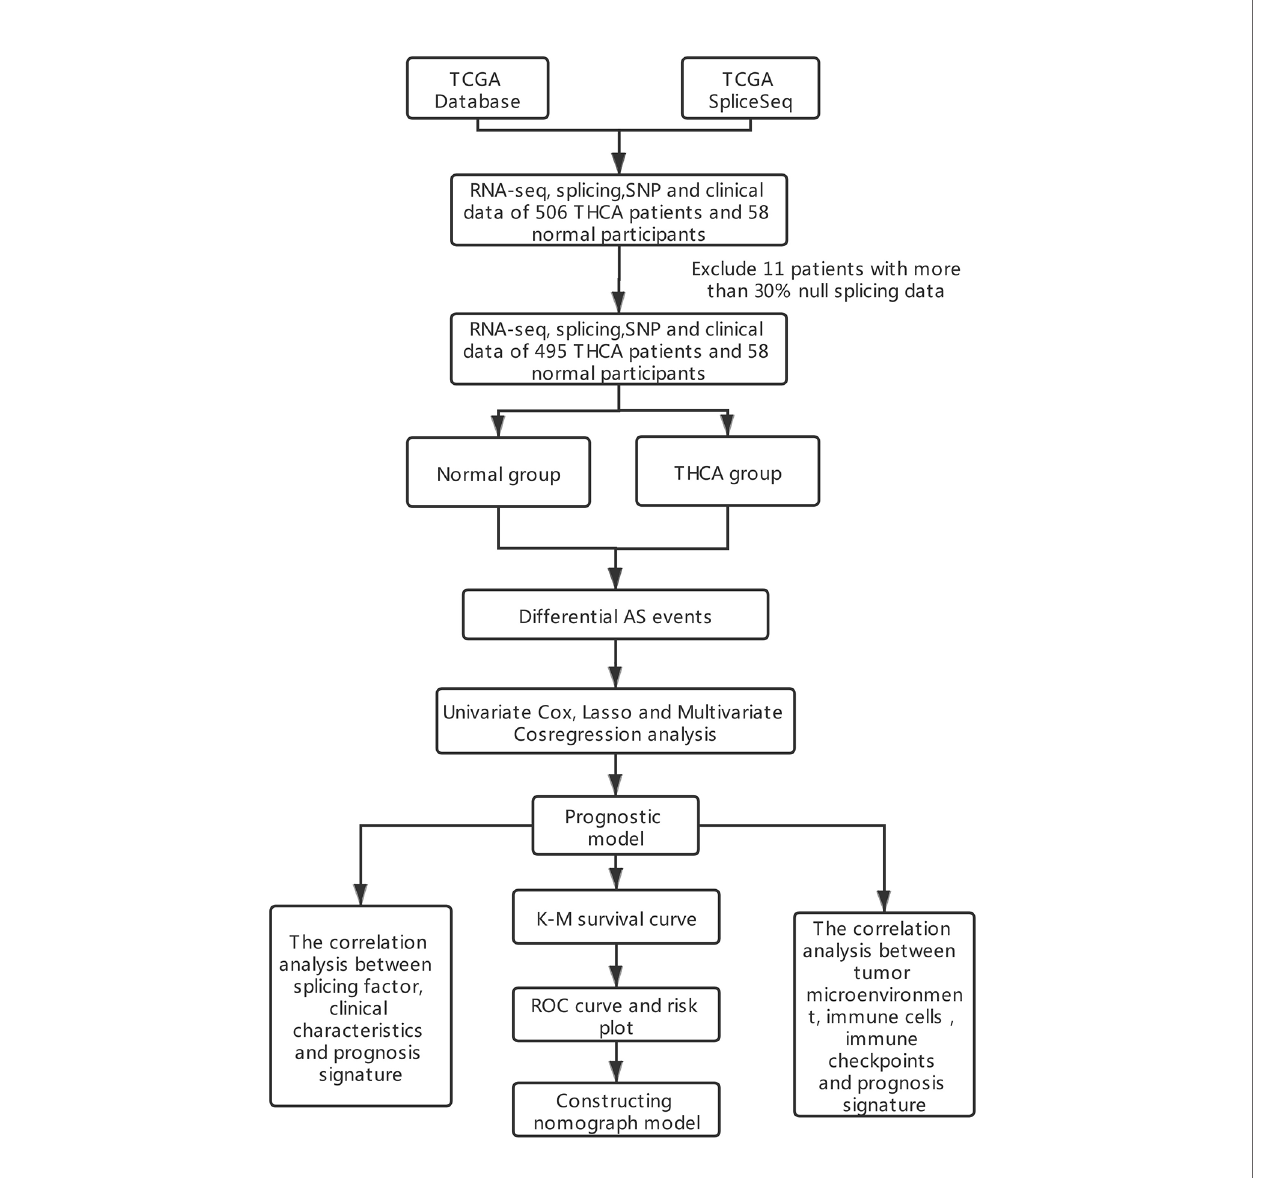
FIGURE 1 | Flow diagram of this